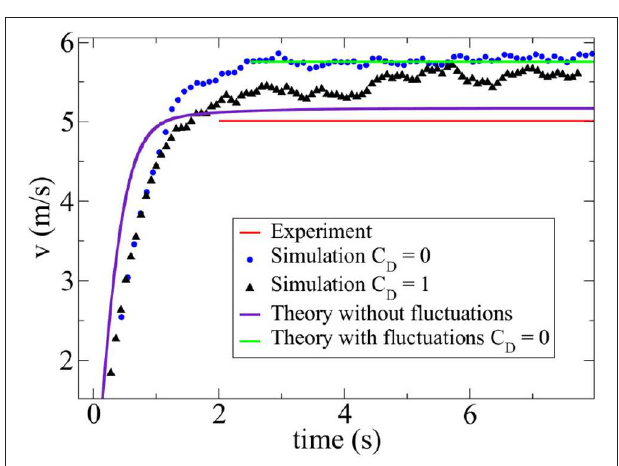
FIGURE 13 | Velocities measured 20 cm above the floor. The red line shows u 2 z where u z is the vertical component of the the experimental average velocity. The blue circles show simulation measurements taken at the same q(cid:10) (cid:11) location but as a function of time. The indigo line shows a semi-analytic prediction derived from Equations (11) and (12) in Biggins [ 4], which is based on a fluctuation-less model. The green horizontal line shows the analytic prediction of Equation (17) and should be compared with the simulation of the velocity at the floor. The triangles show simulations with air-drag